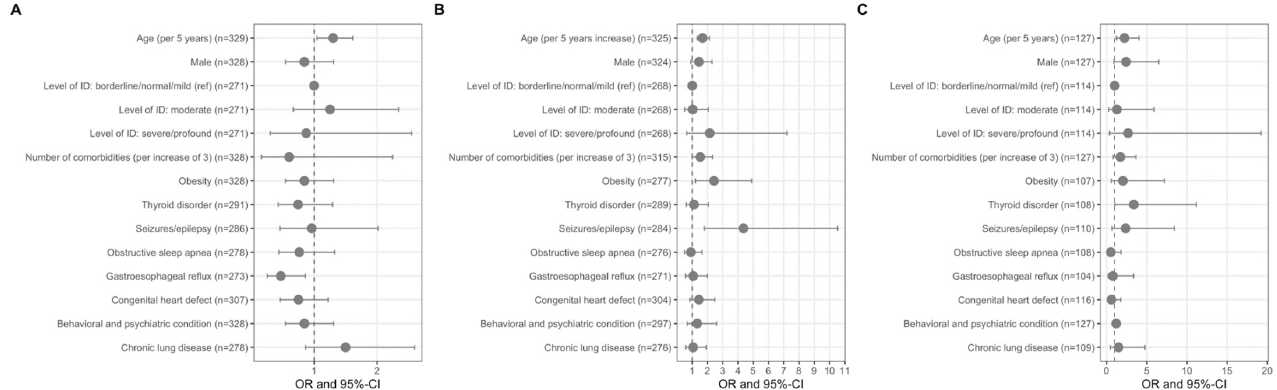
Figure 2. Risk factors associated with adverse outcomes of COVID-19 in children with DS. Associations with ( A ) shortness of breath, ( B ) hospitalisation, and ( C ) acute respiratory distress syndrome (ARDS) in symptomatic COVID-19 patients with DS from the T21RS survey estimated in adjusted logistic regression models (odds ratios (OR) and 95% confidence intervals (95% CI)). Associations with age and gender were adjusted for the data source (caregiver versus clinician survey) and associations with living situation, level of IDD, and comorbidities were adjusted for age, gender, data source, and country of residence. Abbreviations: IDD, intellectual and developmental disabilities; ref, reference category.